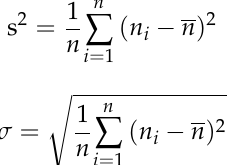
Figure 8. Relative error of the three repeated measurements. Equations (14) and (15) give the calculated population variance and standard deviation of relative error, which are 4.4370 × 10 − 5 and 6.6611 × 10 − 3 , respectively. These results show that our measurements are relatively stable.